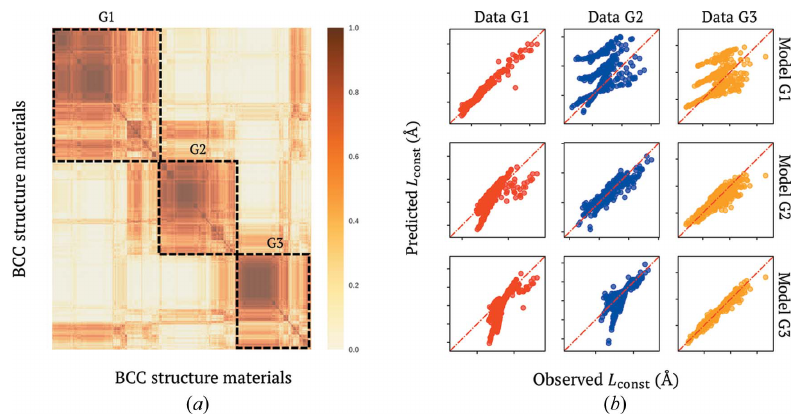
Figure 5 ( a ) The similarity matrix between materials for the L const prediction problem yielded by the regression-based committee voting machine. This similarity matrix can be approximated as three disjoint groups of materials denoted G1, G2 and G3. ( b ) Confusion matrices measuring linear similarities among materials in each group, as well as dissimilarities between models generated for materials in different